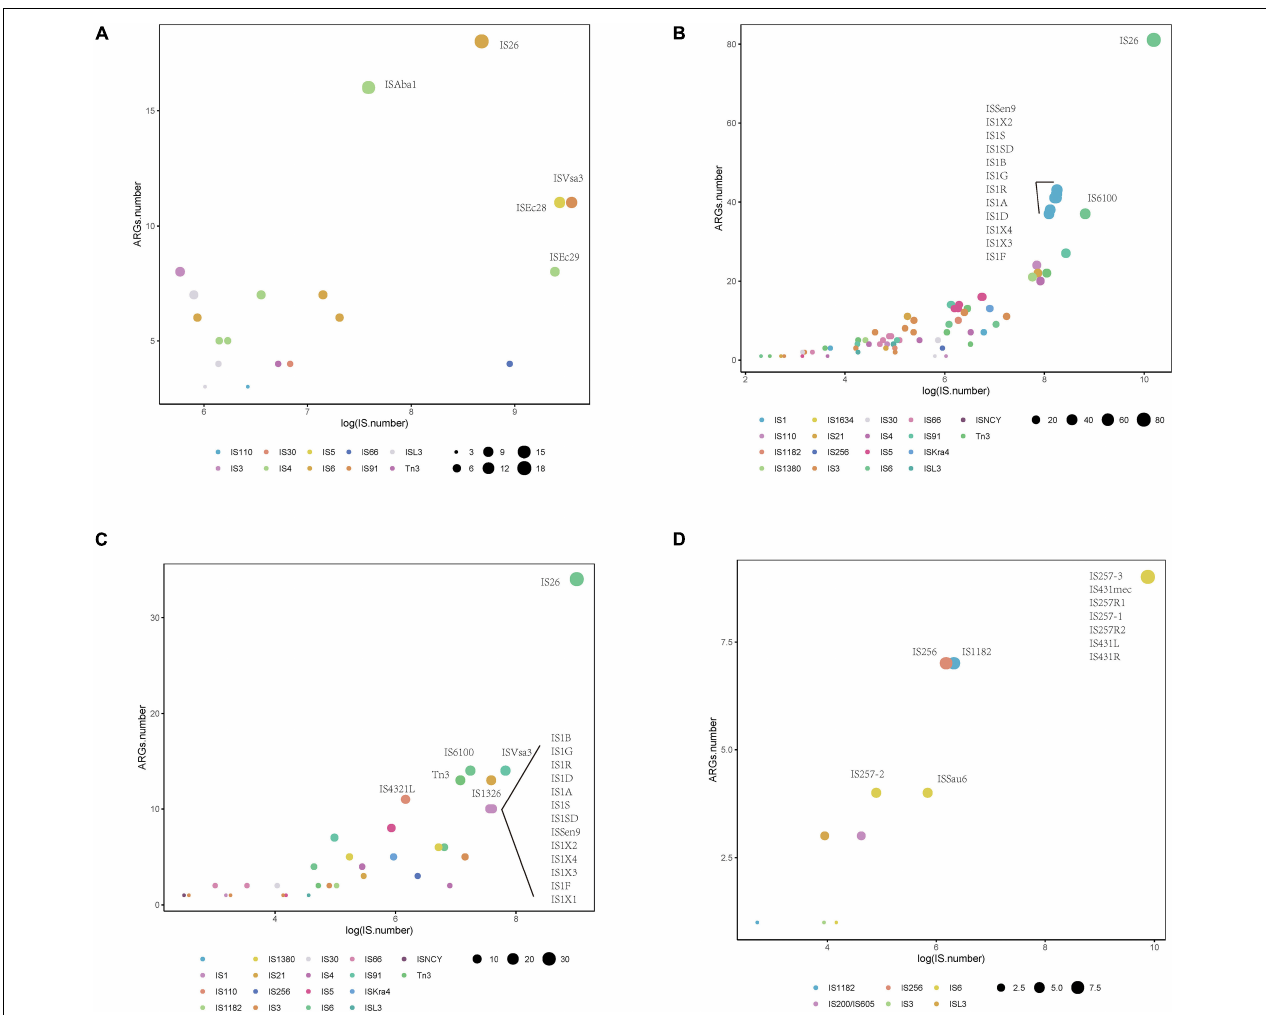
FIGURE 5 | Distribution of Insertion sequences (ISs) with statistically significant association with different types of antibiotic resistance genes (ARGs) within a 10 kb distance. Different colors show various IS, and the size of the circles indicate the presence of their associations with ARGs in (A) A. baumannii , (B) E. coli , (C) S. enterica, and (D) S. aureus